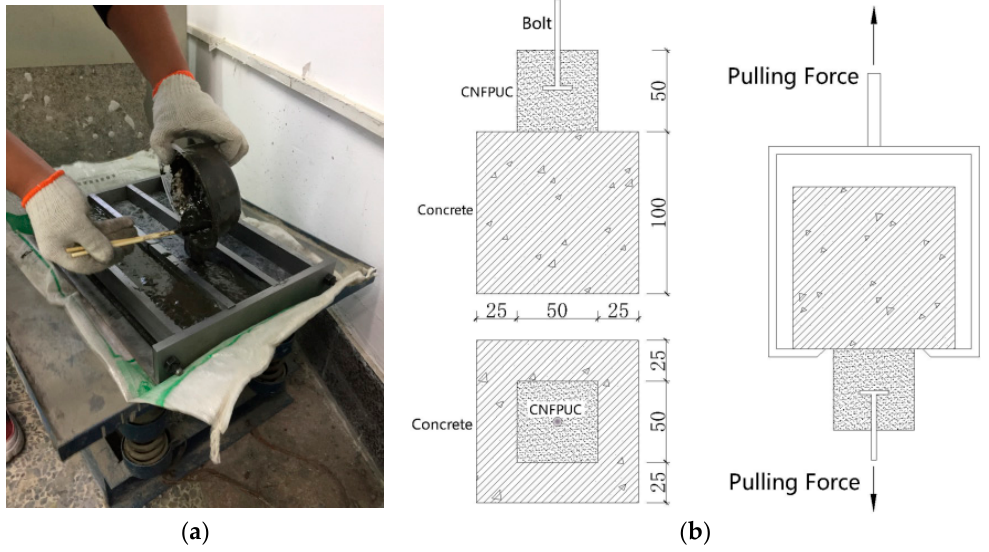
Figure 1. Vibratory compactness of specimens and their dimensions. ( a ) Specimen vibration compactness; ( b ) drawing of test piece size (mm).